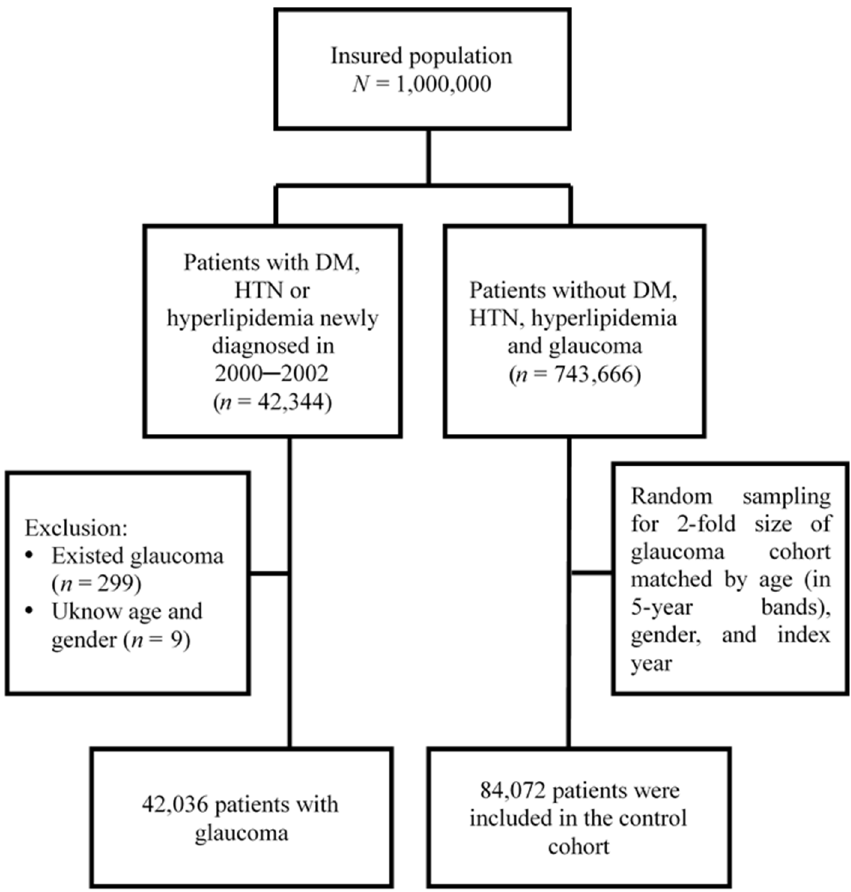
Figure 1. Flow chart of the study population